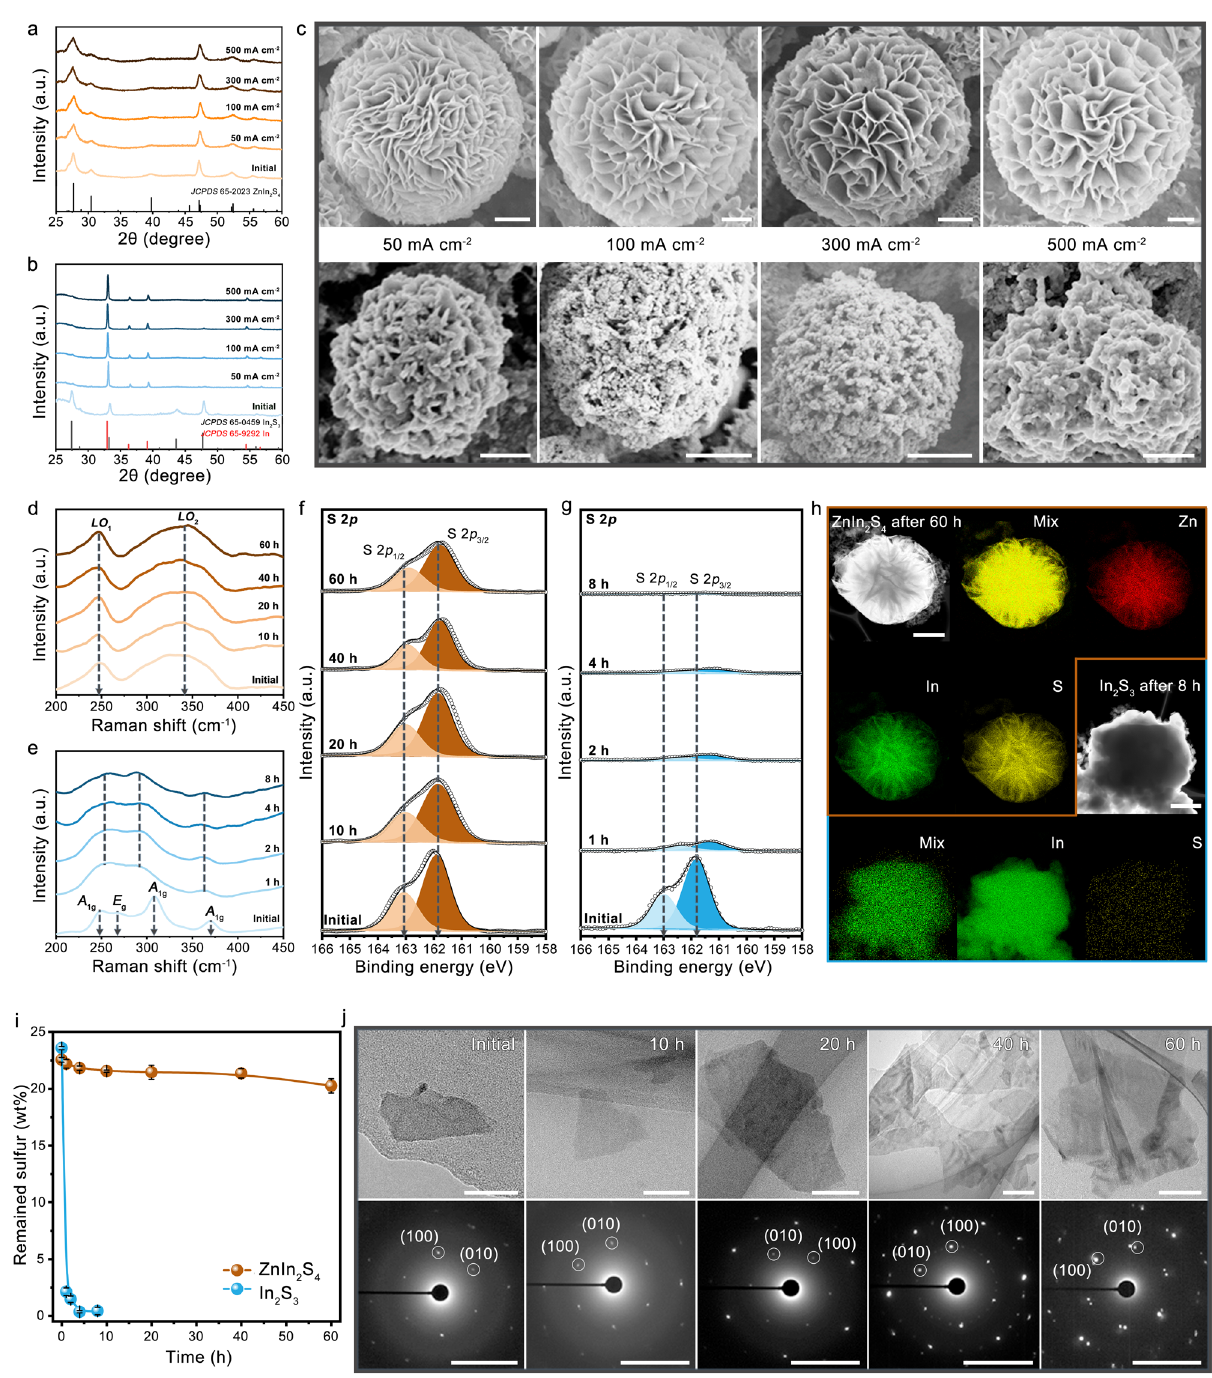
Fig. 3 Structural stability of ZnIn 2 S 4 . a , b XRD patterns of ZnIn 2 S 4 ( a ) and In 2 S 3 ( b ) after CO 2 /Subscript> electrolysis under various current densities for 10min. c Corresponding SEM images of ZnIn 2 S 4 (above) and In 2 S 3 (bottom). Scale bars, 1 μ m (above) and 500nm (bottom). d – g Raman spectra of ZnIn 2 S 4 ( d ) and In 2 S 3 ( e ), and S 2 p XPS spectra of ZnIn 2 S 4 ( f ) and In 2 S 3 ( g ) after CO 2 electrolysis for various times at 300mAcm − 2 . h STEM-EDX elemental mappings of ZnIn 2 S 4 (scale bar: 1 μ m) and In 2 S 3 (scale bar: 600nm) after running for 60h and 8h at 300mAcm − 2 , respectively. i SEM-EDX measurements of the remained sulfur in catalysts after running for various times at 300mAcm − 2 . The error bars represent the standard deviation of three independent measurements. j TEM (above, scale bars: 50nm) and SAED patterns (down, scale bars: 5 1/nm) of ZnIn 2 S 4 catalyst after CO 2 electrolysis for various times at 300mAcm − 2 of ef fi cient and durable catalysts for commercial-scale electro- indium sul fi de catalyst modulated by Zn. The extraordinary catalyst synthesis of formate. stability can be explained by the increase of In − S covalency, which substantially prevents sulfur dissolution during CO 2 RR. We achieved selective and fast CO 2 -to-formate conversion with a formate FE of 99.3% and a notable formate production rate of 8,894 μ mol cm − 2 h − 1 . These fi ndings will advance the development